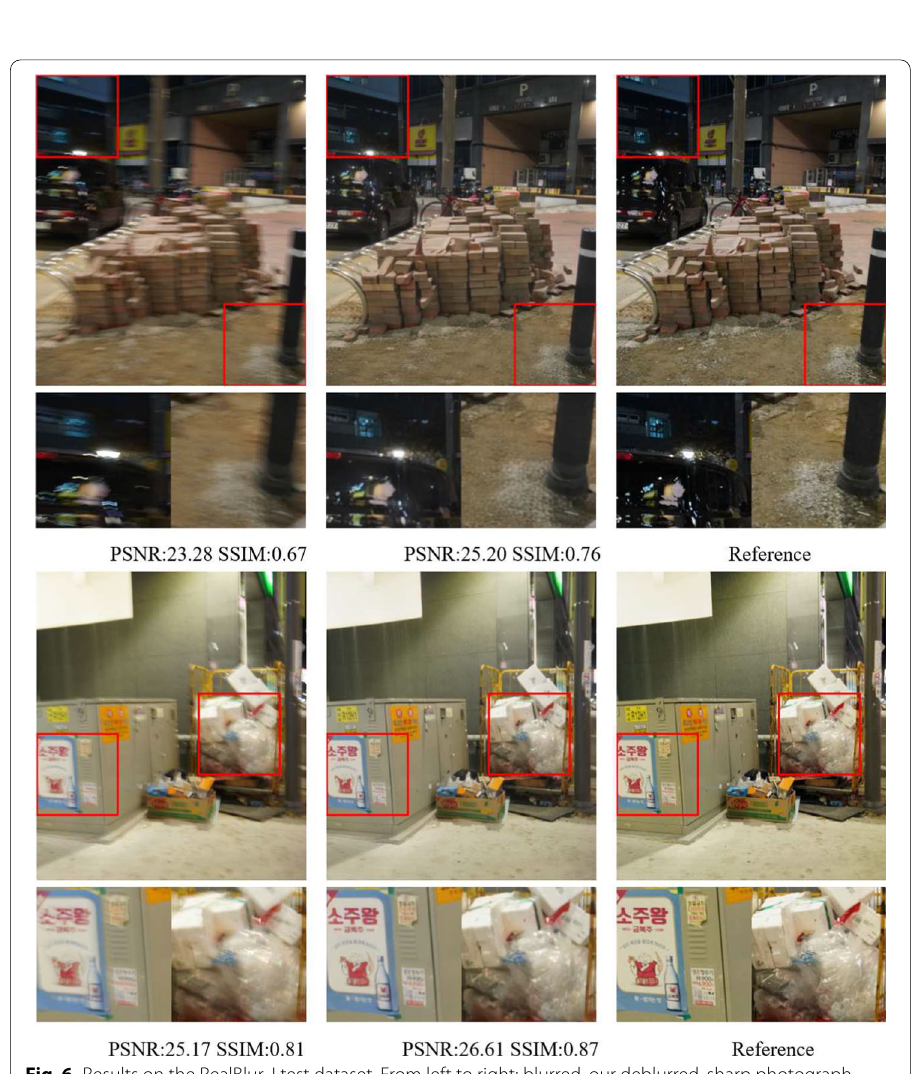
Fig. 6 Results on the RealBlur-J test dataset. From left to right: blurred, our deblurred, sharp photograph our model was only trained on it. The results shown in Table 4, except for our method, were trained on Rain14000, Rain800 and Rain1800. Our method was never trained on Rain14000 dataset, which has the largest amount of data. As for the test set of Rain1800, it is divided into two parts, Rain100H and Rain100L, however, our model trained only on the Rain800 dataset can achieve PSNR 18.30 and SSIM 0.476 on Rain100H and SSIM 0.865 and PSNR 26.21 on Rain100L.